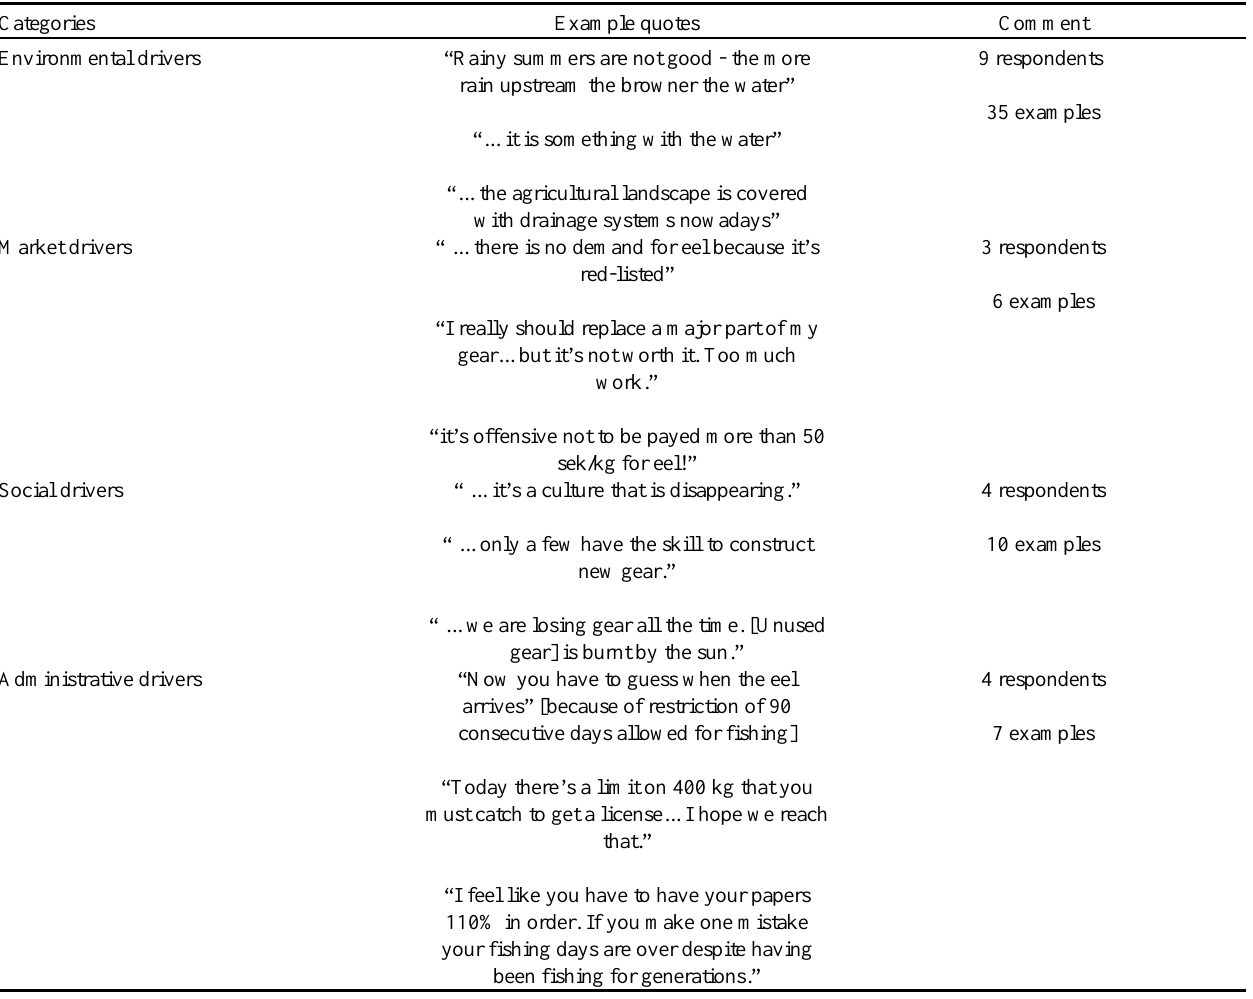
Table 4. Summary of drivers of change for eel fishing according to stakeholders structured into four classes of drivers. Nine respondents. Comments reflect number of respondents falling into the category and number of examples